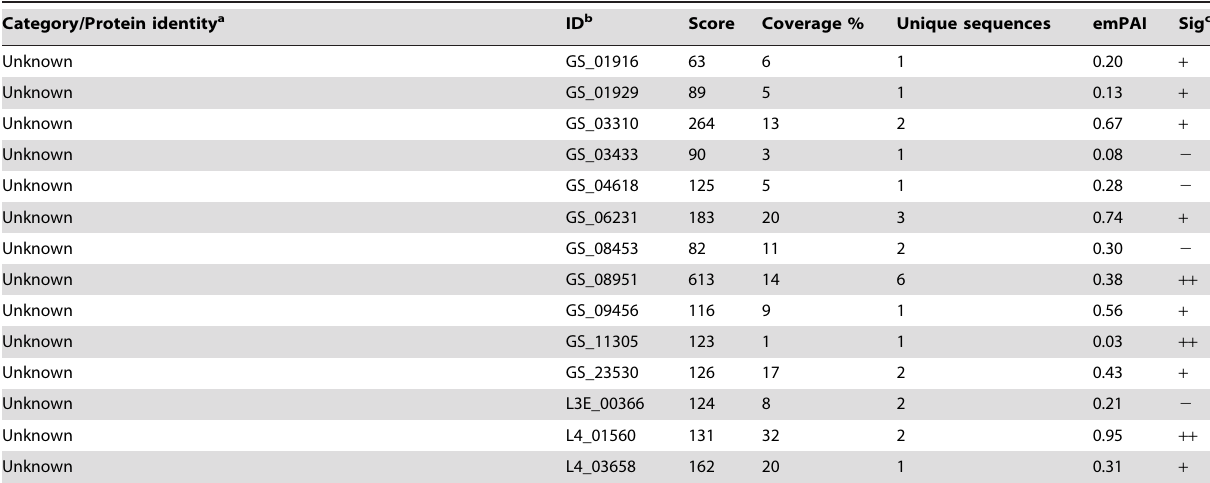
from L3-egg, L3-lung and L4 ES products, respectively, were predicted to be either a classical or non-classical secreted protein (Tables 1–3).